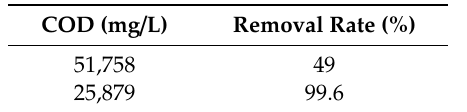
Table 1. Chemical oxygen demand (COD) values and respective removal rate (%) for oily water after treatment in photoreactor with the 8% TiO 2 / P(VDF–TrFE) membrane after seven hours under sun